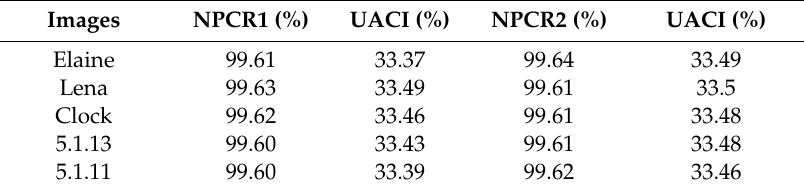
Table 9. NPCR and UACI values in the key sensitivity analysis.